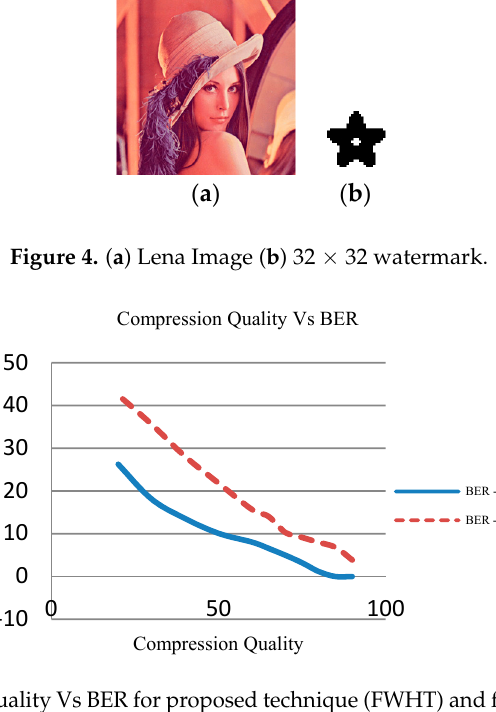
Figure 5. Compression Quality Vs BER for proposed technique (FWHT) and for similar DCT technique. Table 2. Extracted watermark After Different Attacks.